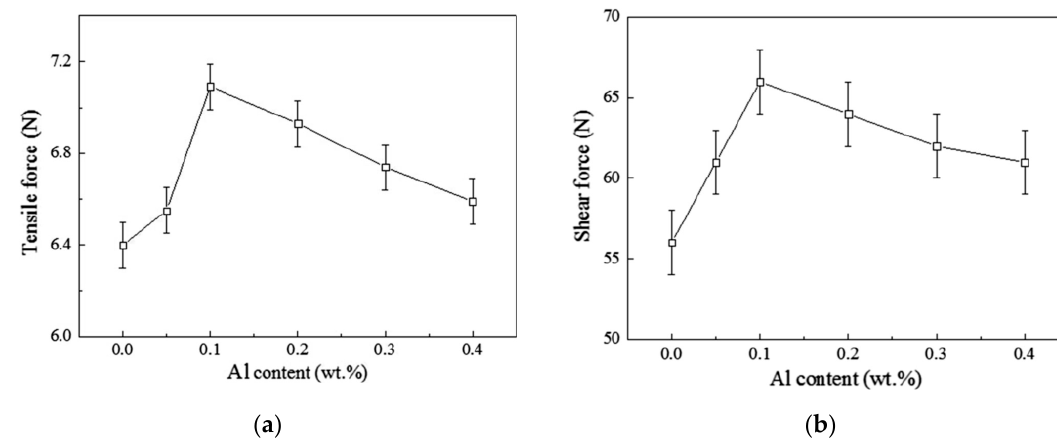
Figure 3. The mechanical properties of SAC105–xAl solder joints: ( a ) Tensile force; ( b ) shear force [30].